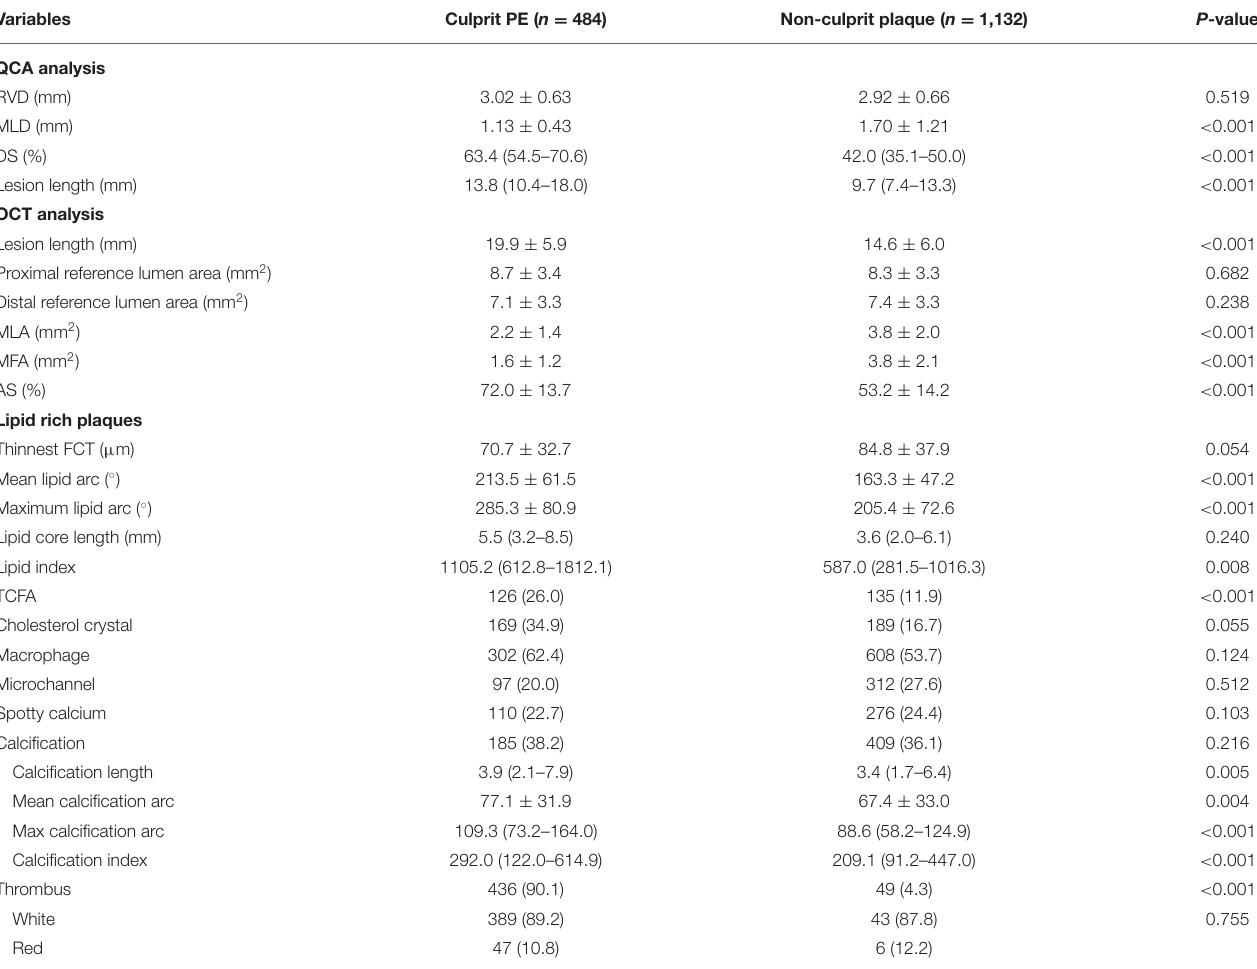
TABLE 2 | QCA and OCT analysis of culprit and non-culprit plaques in patients with culprit plaque erosion.